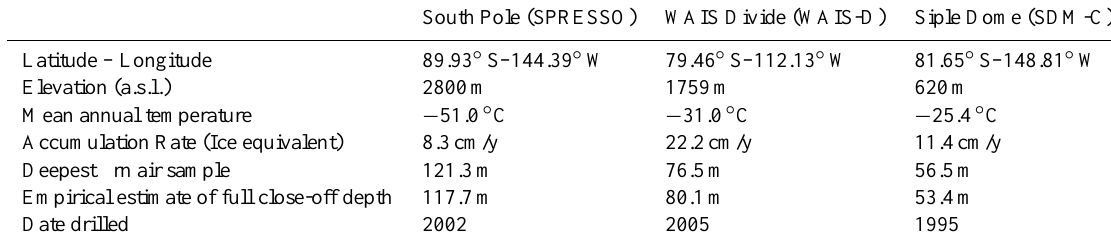
Table 1. Site characteristics for the three locations used in this study. Full close-off depth as calculated with Eq.